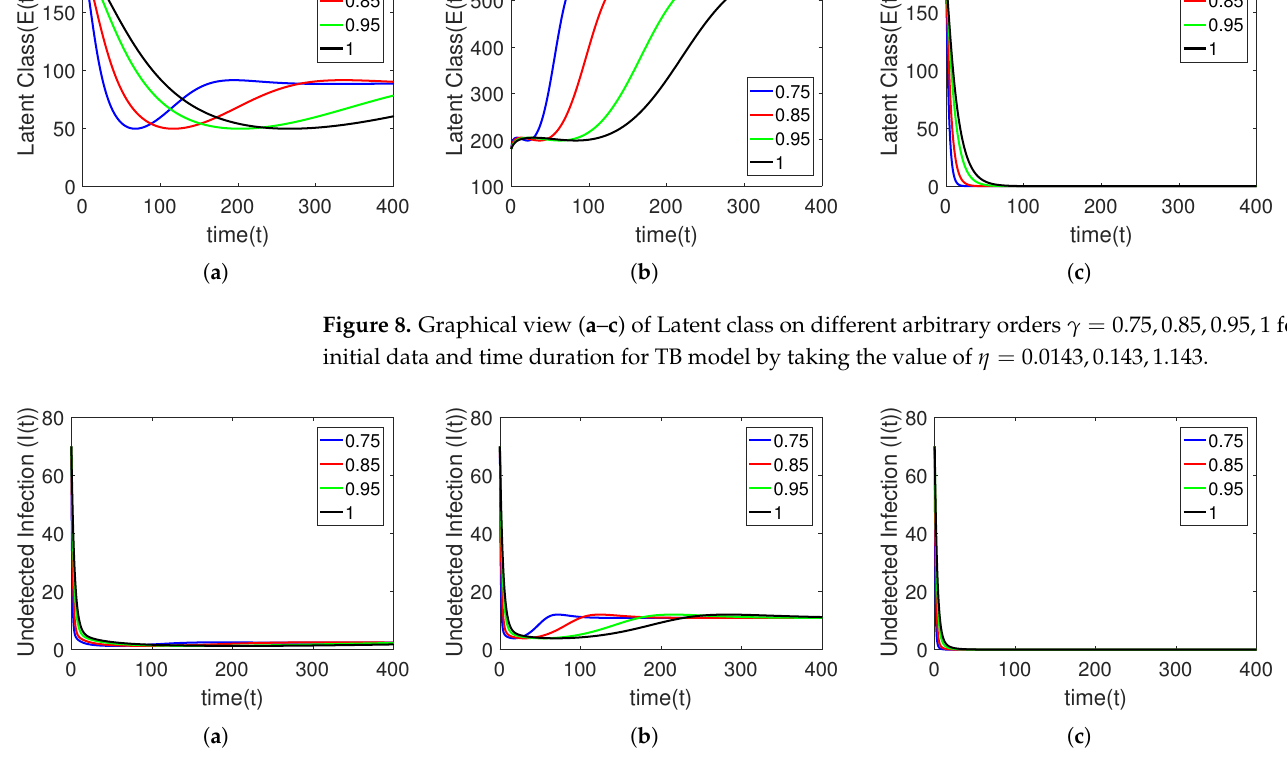
Figure 9. Graphical view ( a – c ) of Undetected infected class on different arbitrary orders γ = 0.75, 0.85, 0.95, 1 for initial data and time duration for TB model by taking the value of η = 0.0143, 0.143,